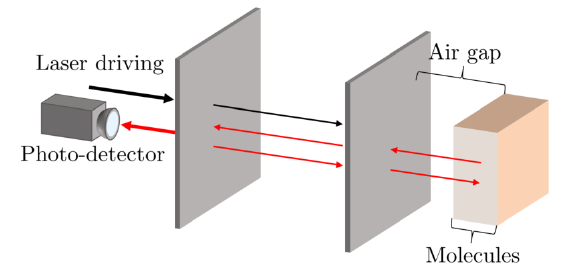
Figure 2. In this paper, we propose an alternative way of using Fabry-Pérot cavities in sensing applications. Here, the substance which we want to analyse is some distance away from the resonator. Hence, we refer to this type of sensor in the following as a remote Fabry-Pérot cavity sensor. If the sample contains atomic particles with optical transitions near the resonance frequency of the sensor, the coherent back reflection of light affects the overall transmission rate of the system. The above experimental setup effectively consists of many mirrors. The measurement signal is an effective frequency-dependent reflection rate of the molecules and, as we shall see below, provides information about their